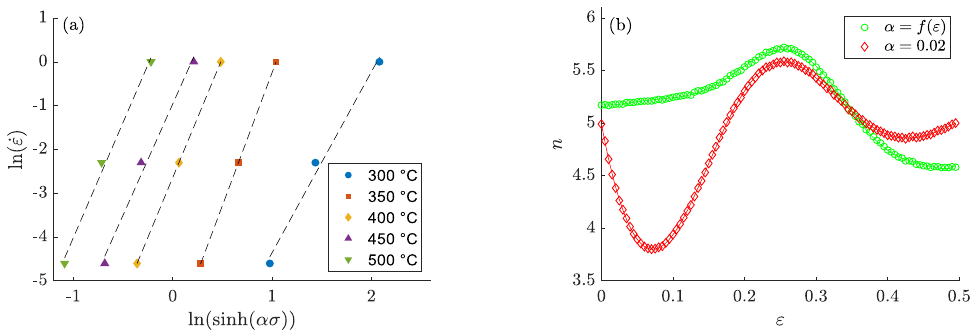
Figure 4. ( a ) The linear relationships for determining n . For this plot, α is defined as a function of ε , and ( b ) the temperature-averaged values of n by imposing different values of α